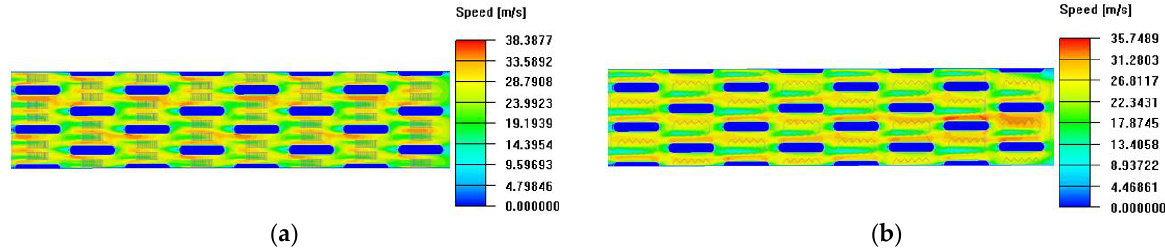
Figure 8. Speed cloud map in the basin before and after improvement; ( a ) original model; ( b ) improved